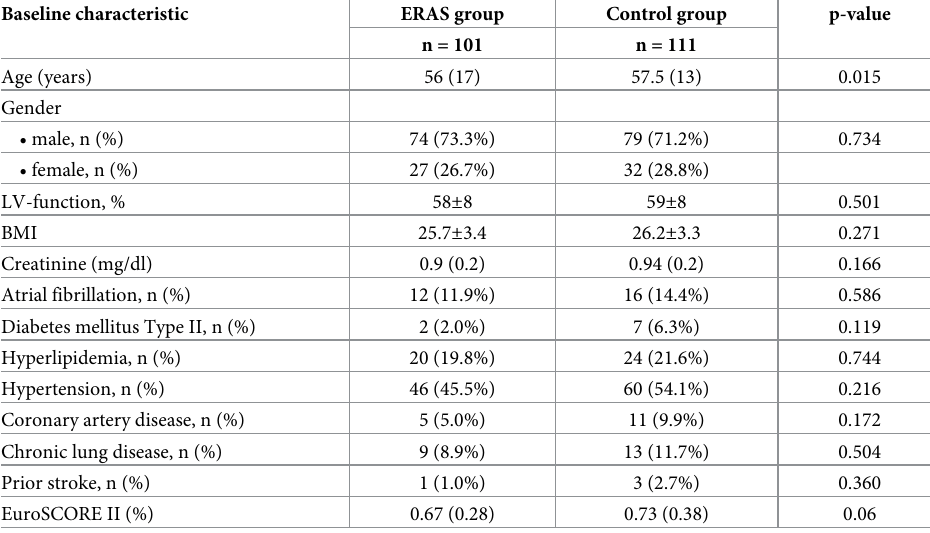
Table 1. Preoperative baseline